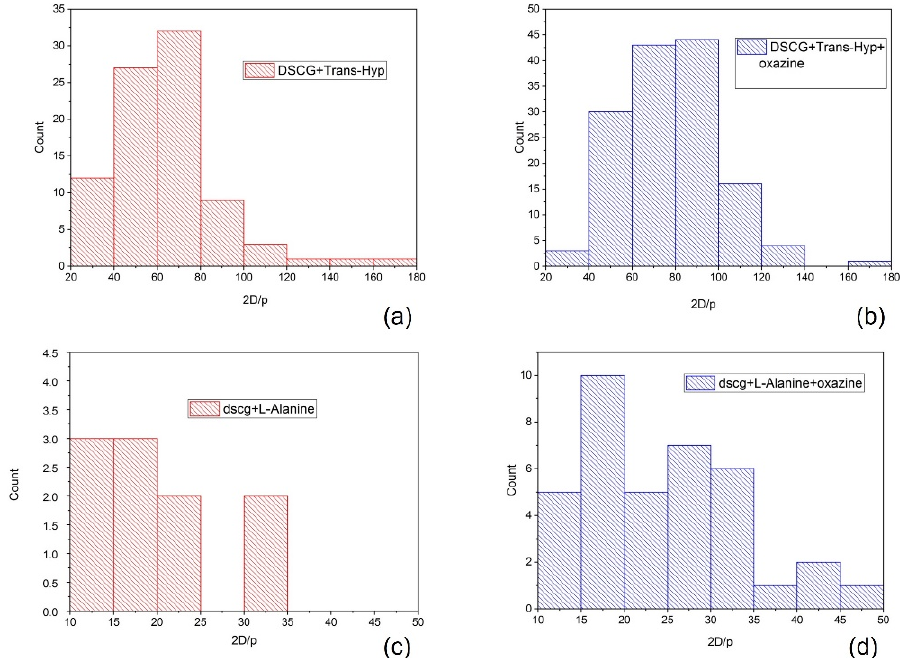
Figure 5. Chirality parameter distribution for: ( a ) DSCG + Trans-Hyp; ( b ) oxazine-doped DSCG + Trans-Hyp; ( c ) DSCG + L-alanine; and ( d ) oxazine-doped DSCG + L-alanine.